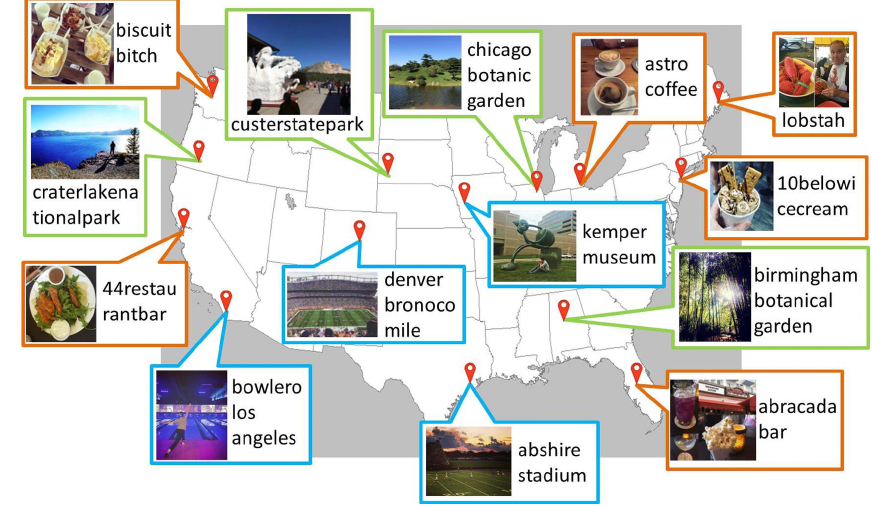
Figure 18. Examples of stationary local words only in our geographic